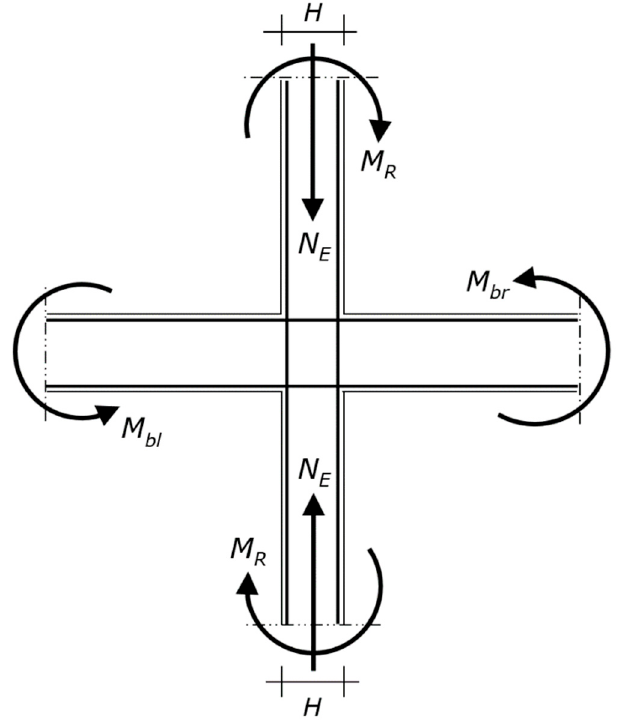
Figure 3. Diagram of the beam–column joint, where M bl and M br are the overstrength plastic moments that induce tension on the upper and lower fibers of the beam section, respectively (i.e., M bl and M br are obtained from the relevant design plastic moment of the beam multiplied by the overstrength factor). The bending moments M R are given by the rotational equilibrium. Since the upper column is equal to the lower column, M R = ( M bl + M br ) / 2. The axial forces N E are the compressions that have to be transferred by the two columns together with M R .